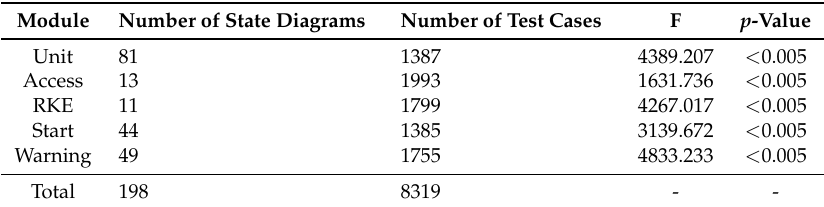
Table 7. ANOVA test results of passive entry start systems (PEPS)